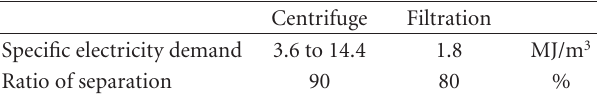
Table 7: Electricity demand and ratio of separation for di ff erent separation technologies (adapted data from [9, 25, 26, 28]). A de- tailed review is available from